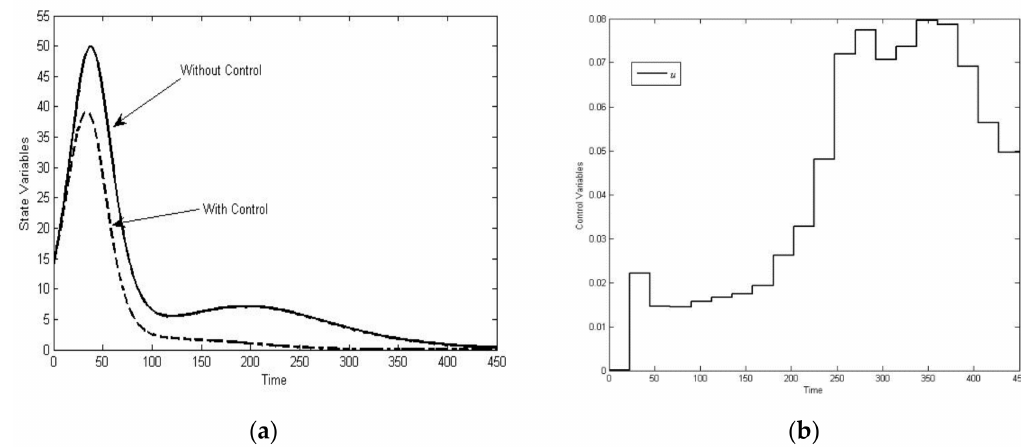
Figure 3. ( a ) Trajectories for larva stage y_2 without control in model (5)–(6) and with optimal control. ( b ) Optimal control to be applied and solution of problem